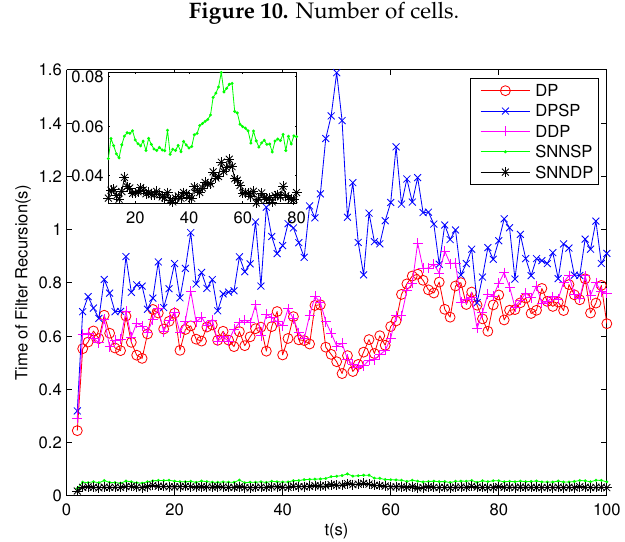
Figure 10. Number of cells.